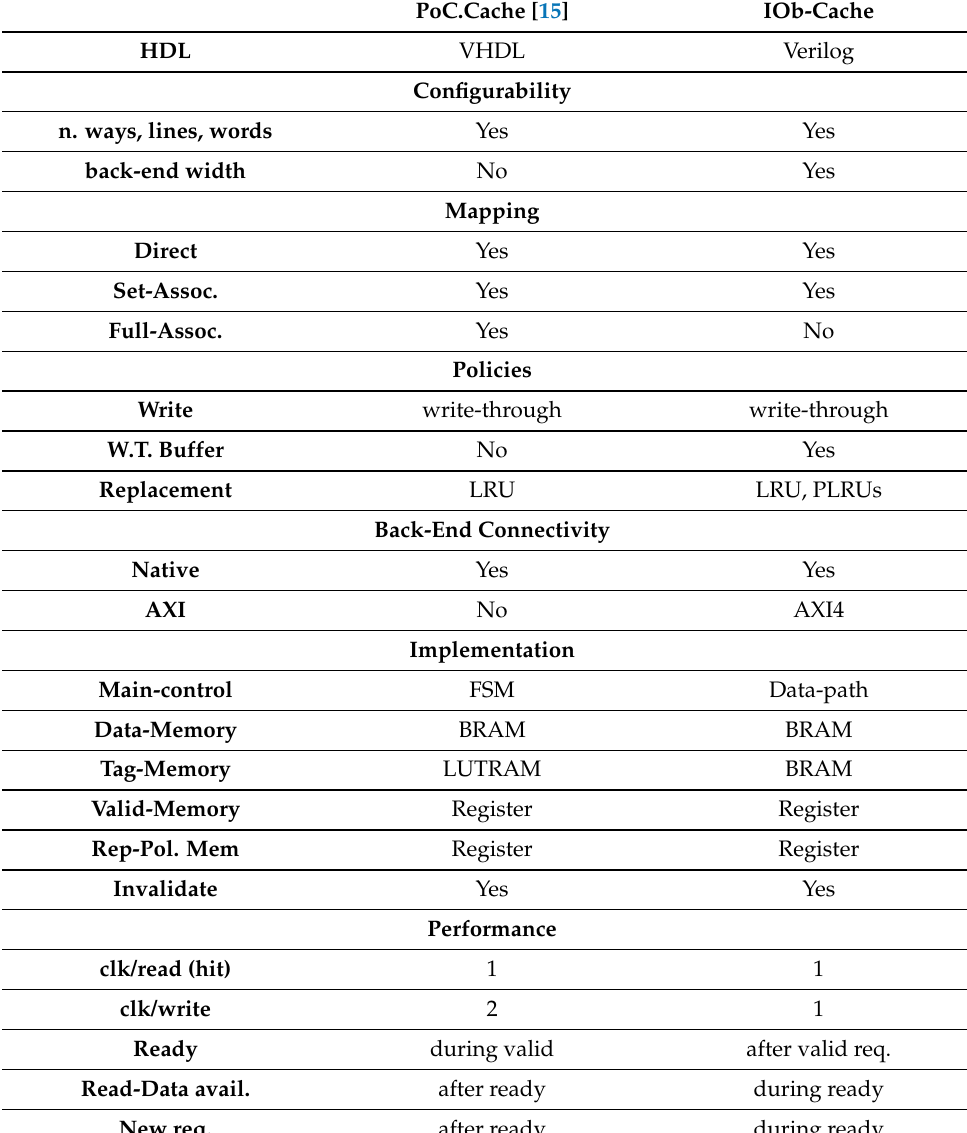
Table 6. Comparison between PoC.cache and